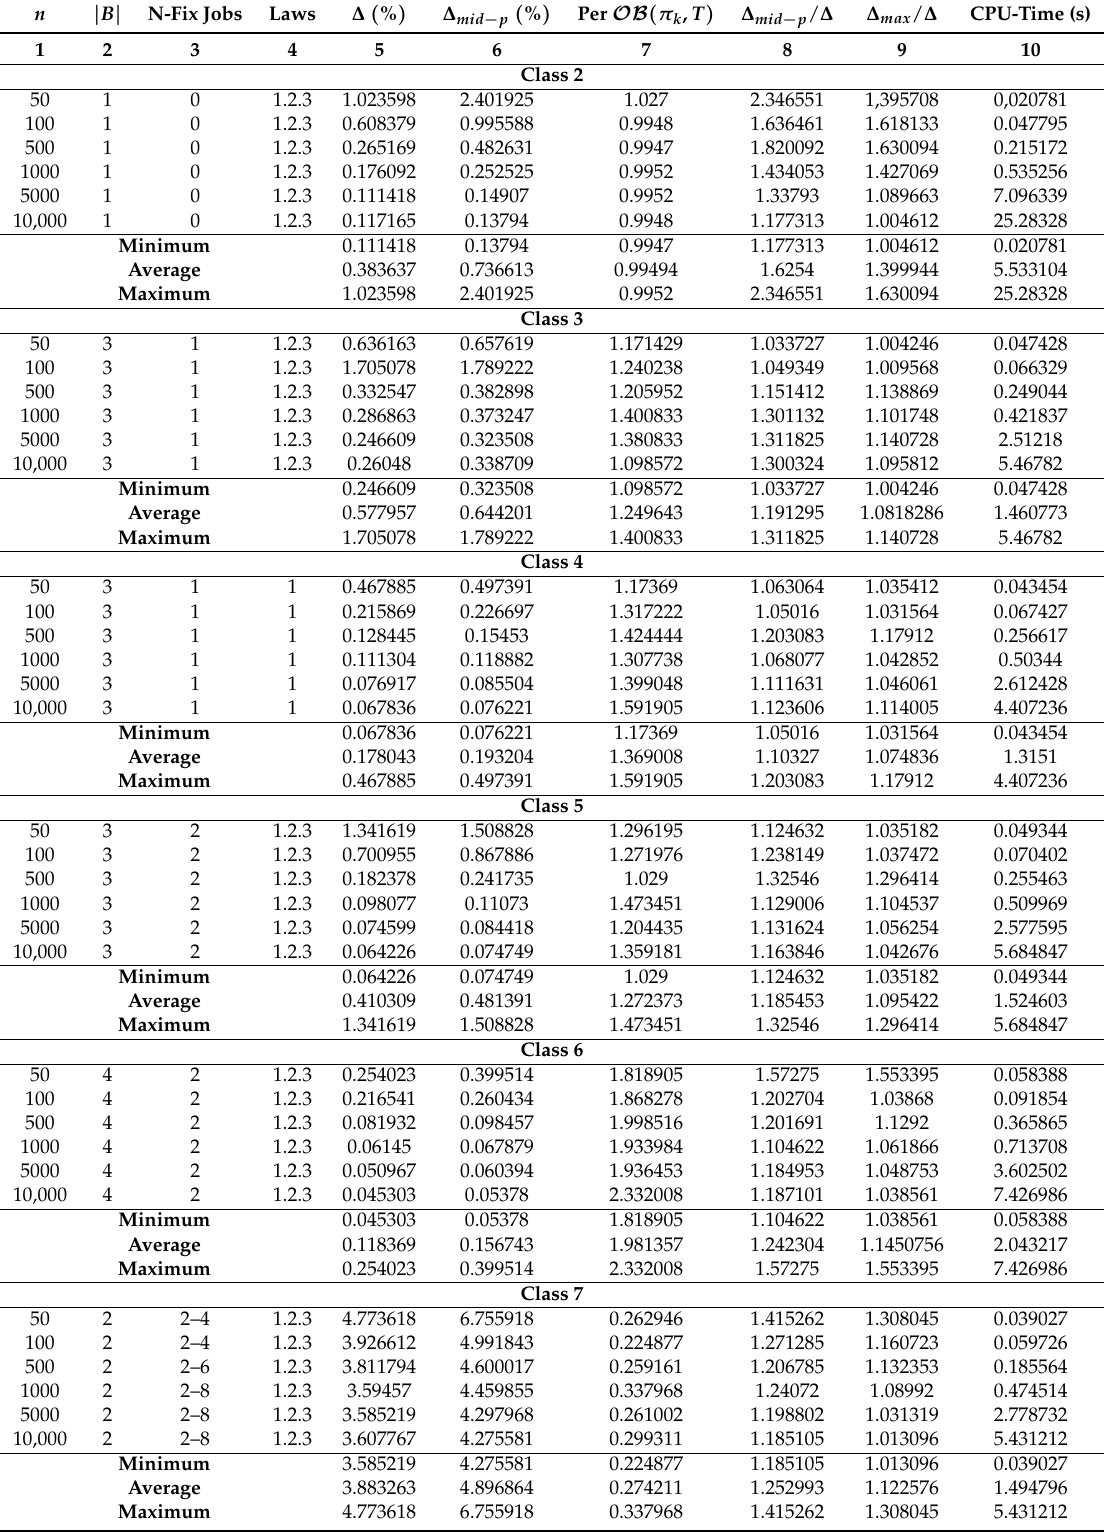
Table 3. Computational results for randomly generated instances from classes